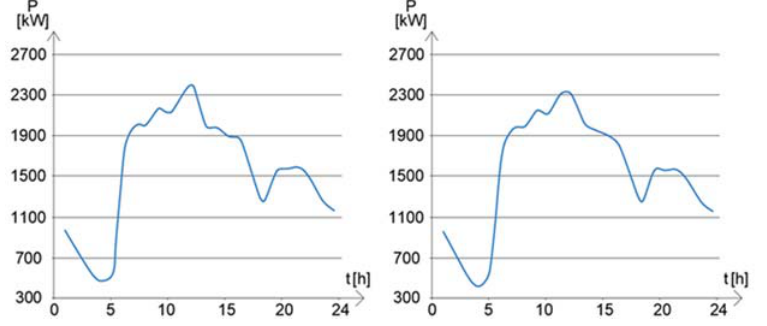
example of consumption, ( b ) another example of consumption.